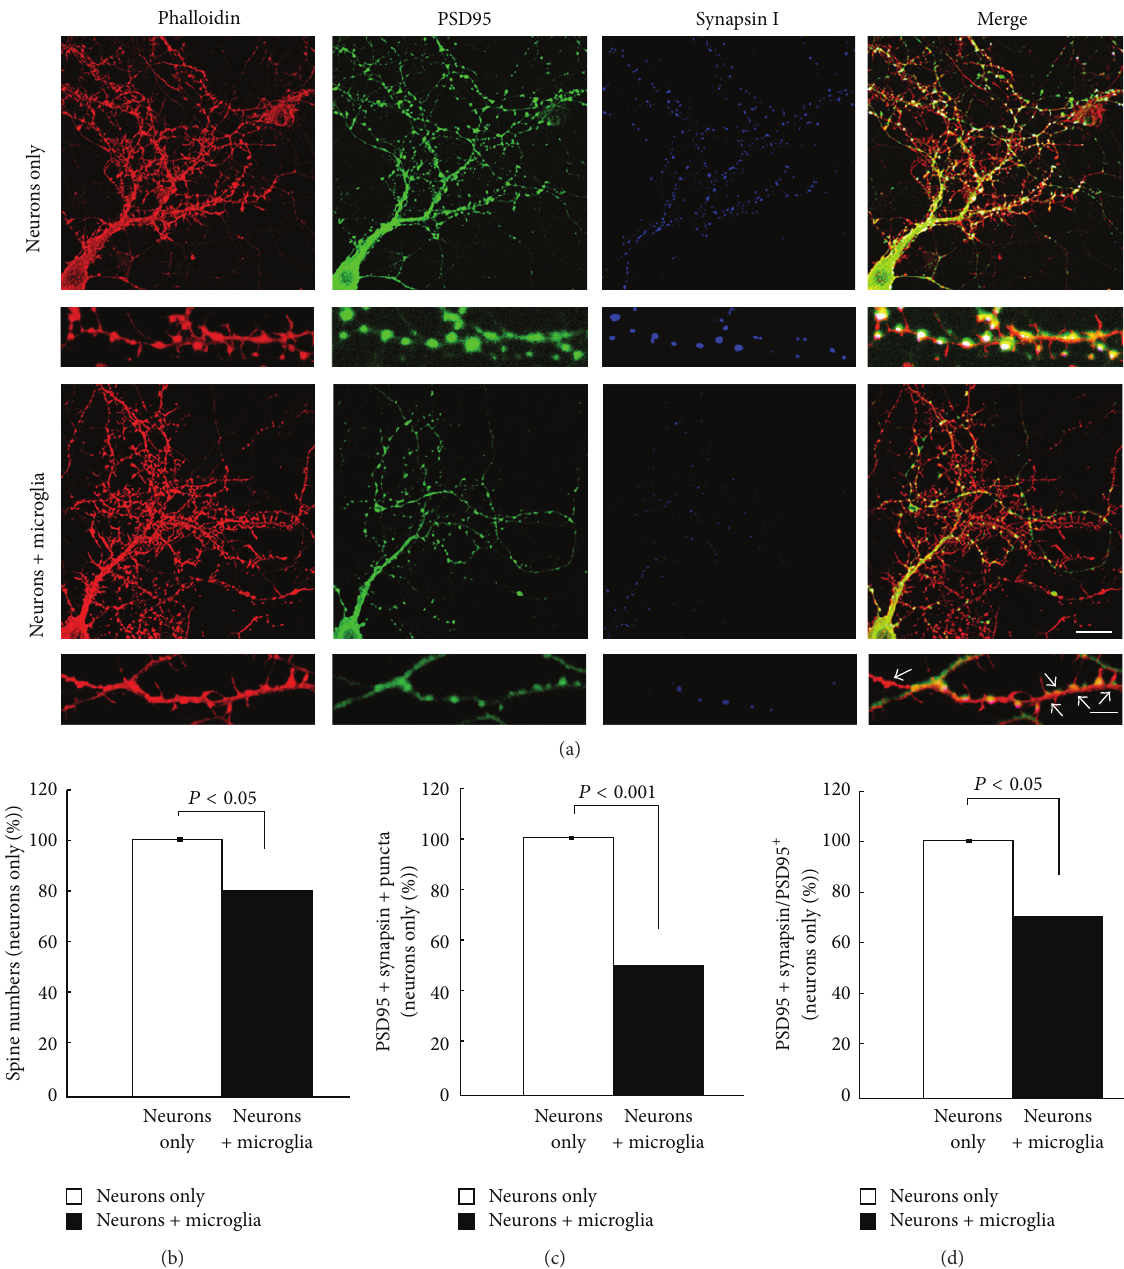
Figure 1: Microglia alter the synaptic density of hippocampal neurons. Hippocampal neurons with or without microglia were stained with PSD 95 (green), synapsin I (blue), and phalloidin (red) (a). The smaller boxes show magnified images. Arrows depict PSD 95 + synapsin 1 − puncta. Scale bars: 20 𝜇 m (upper panel); 5 𝜇 m (lower panel). Quantification of spine numbers (b), PSD 95 + synapsin 1 + puncta (c), and PSD 95 + synapsin 1 + puncta in total PSD 95 + puncta (d) in neurons cultured with or without microglia. Values are presented as mean ± SEM and expressed as a percent of the neurons-only control sample (adapted from